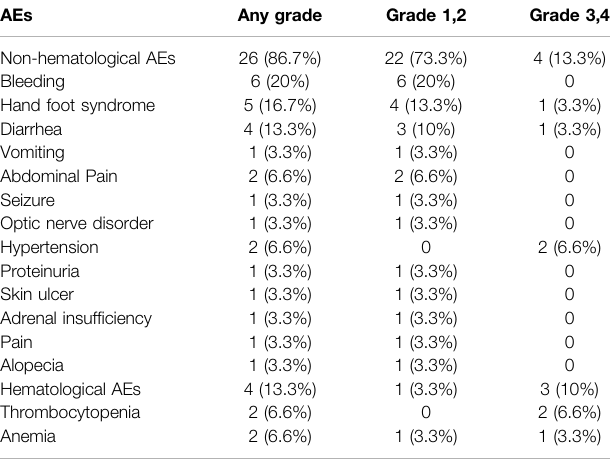
TABLE 3 | Possible treatment-related adverse